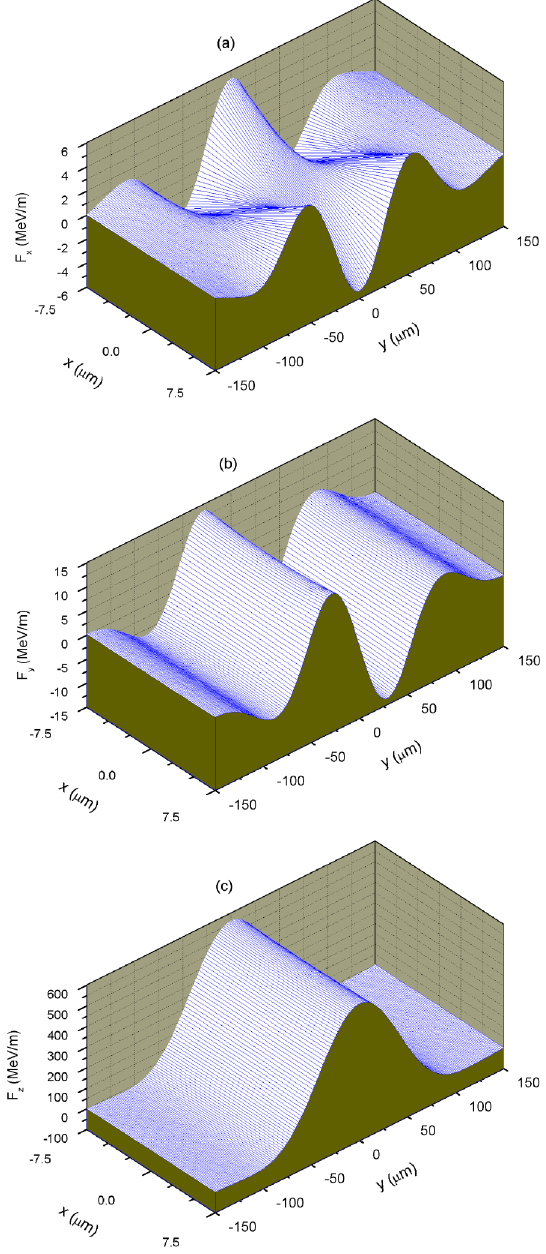
FIG. 17. (Color) Wakefield force configurations for (a). F F , (c). F at z (cid:3) 996 (cid:4) m . F and F are focusing in the region y z x y of j x j < 7 : 5 (cid:4) m and j y j < 29 : 2 (cid:4) m . The acceleration test par- ticles are initially distributed within a rectangle of j x j (cid:12) 5 (cid:4) m equal to 554 : 0 MeV = m at the and j y j (cid:12) 15 : 9 (cid:4) m , with F z center of x (cid:3) 0 and y (cid:3) 0 .